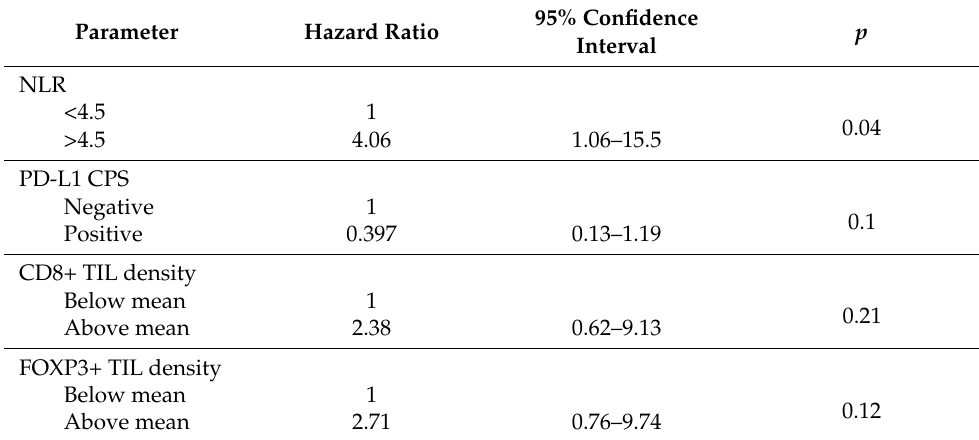
Table 5. Multivariate analysis in relation to the response to induction